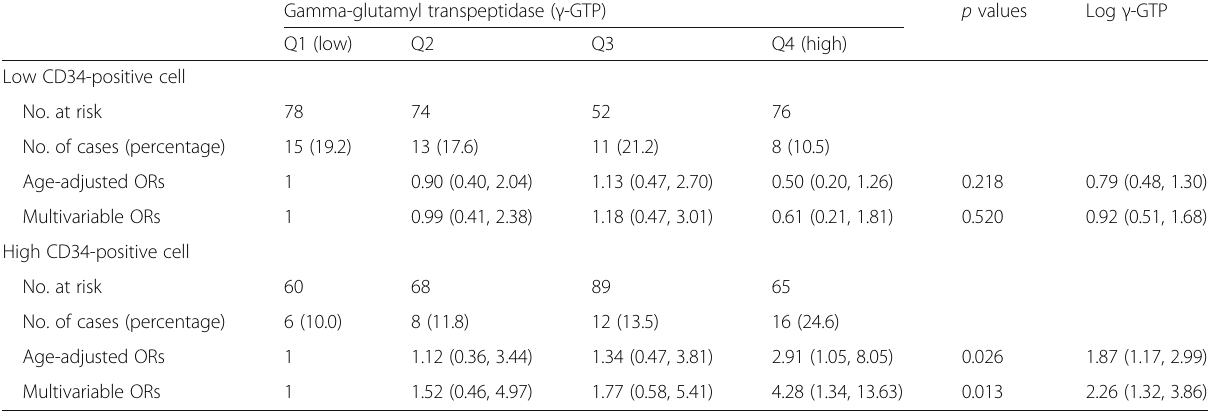
Table 3 Odds ratios (ORs) and 95% confidence intervals (CIs) for atherosclerosis by circulating CD34-positive cell